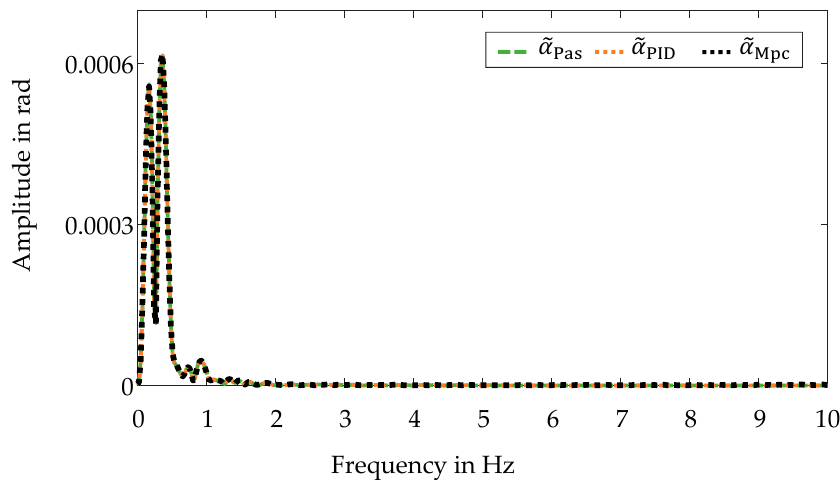
Figure 6. Control Quality Double Lane Change–Self-Steering Behavior–Frequency Spectra.